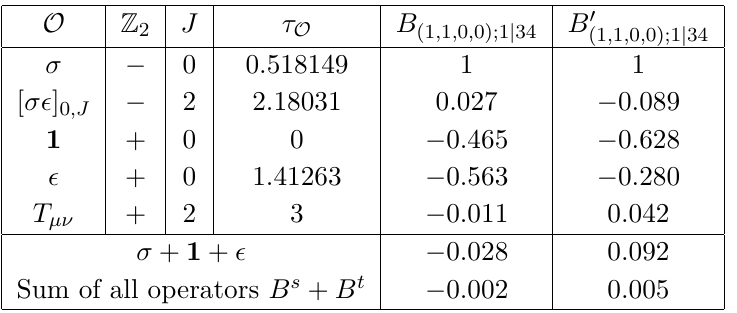
Table 8 . Contribution of each operator to the h (cid:15)σσ(cid:15) i sum rule with v = 1 ; these results include the contribution of the OPE coefficients f . The values are normalized with respect to O i O j O f O l O k O the largest contribution to the sum rule i.e. the σ operator. All other operators contribute at order O (10 − 3 ) and